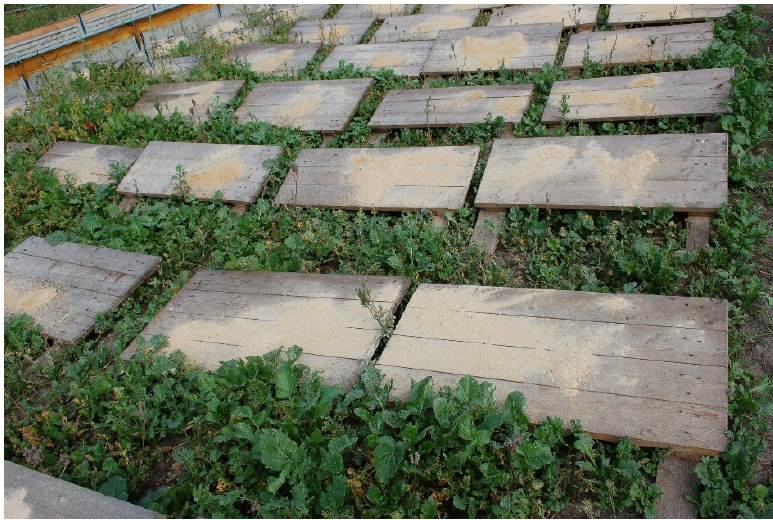
Figure 1. Feed tables on the experimental plot.